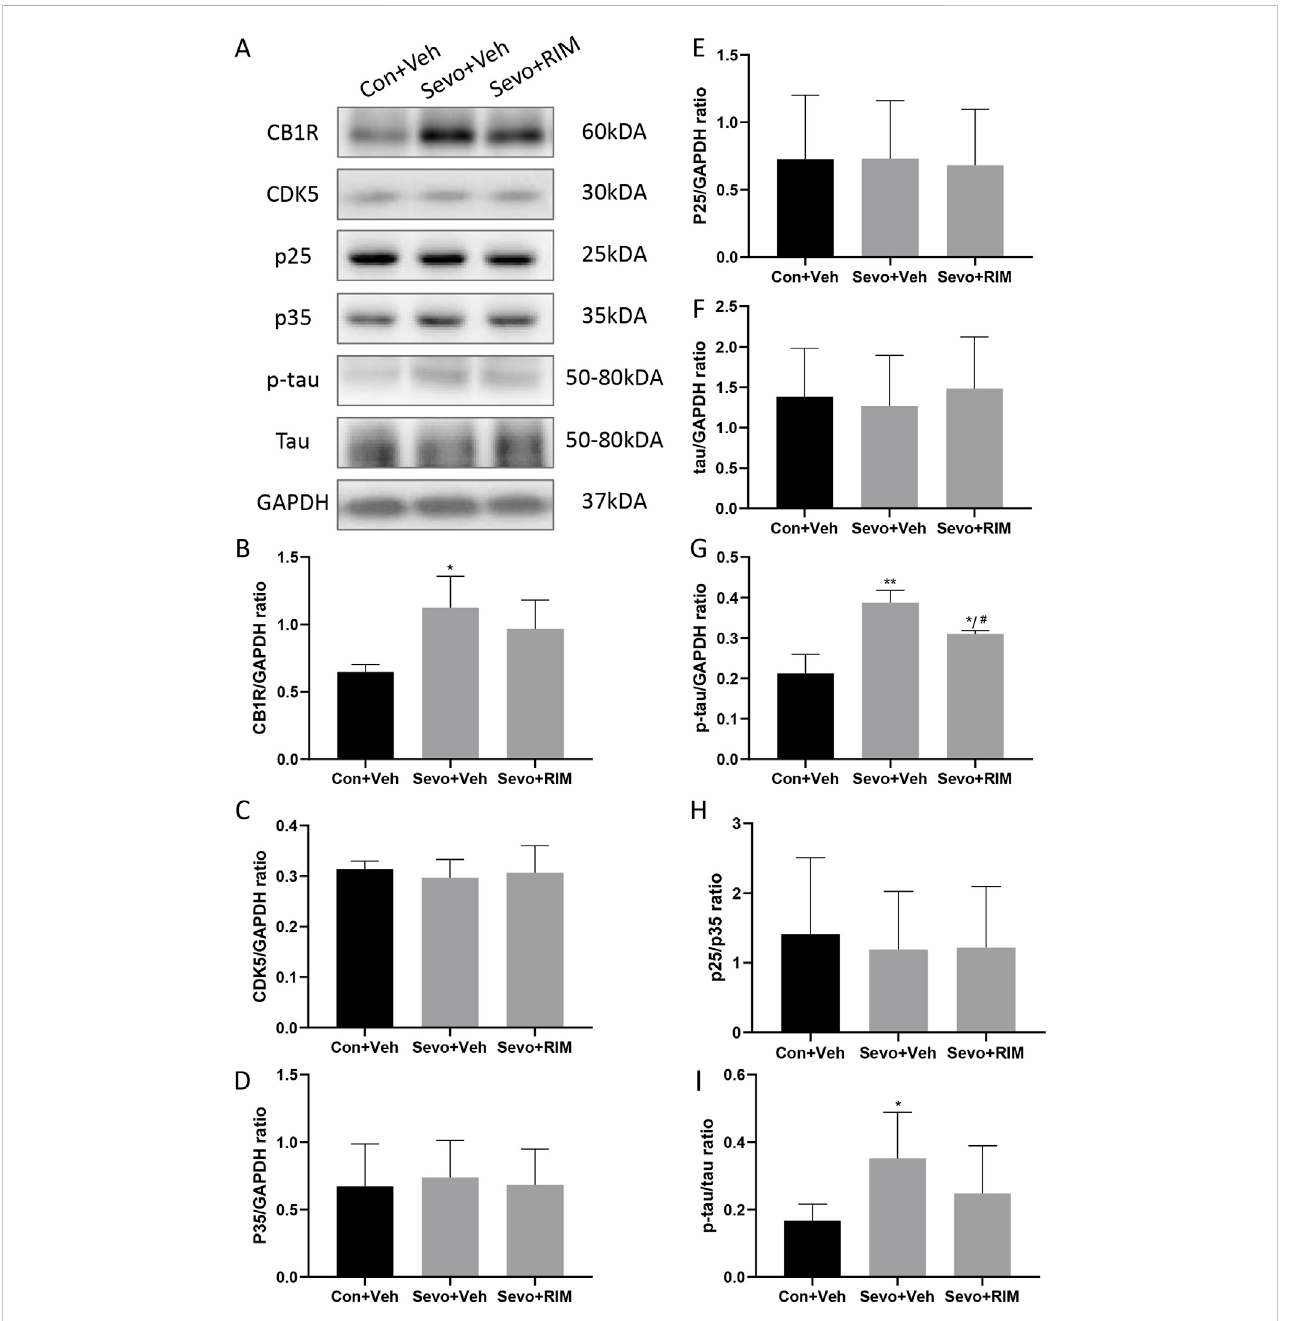
FIGURE 5 Sevo fl urane augmented p-tau expression in the hippocampus of offspring rats. Representative western blots (A) and quantitation (B – I) of western blotting assays ( n = 3 rats/group) showing CB1R, p35, CDK5, p25, tau, and p-tau expression in the hippocampus. Data are summarized as mean ± S.E.M. * p < .05, ** p < .01, vs. the Con + Veh group; # p < .05, vs. the Sevo + Veh